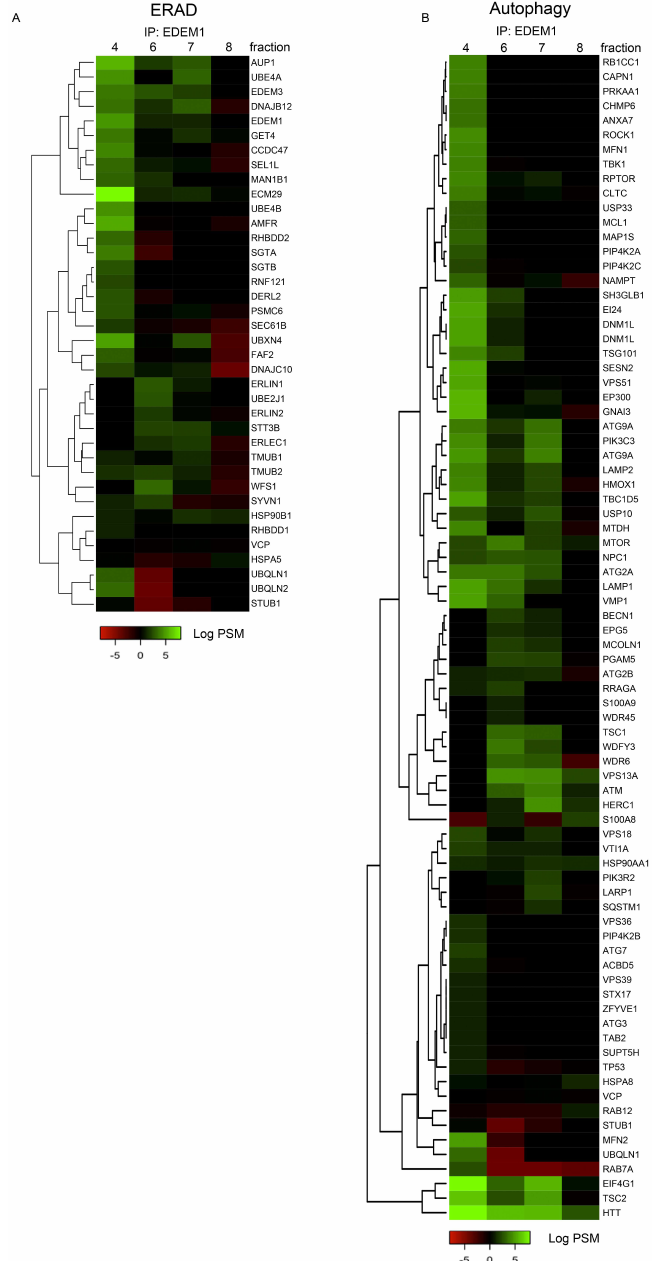
Figure A3. Heatmap of ERAD ( A) and autophagy ( B ) proteins identified, using mass spectrometry for the indicated sucrose gradient fractions that were immunoprecipitated with EDEM1; the eluted samples were separated by SDS-PAGE, followed by in the gel digestion protocol, as described in the Materials and Methods section. Identified proteins were annotated with GO terms from UniProt database, and entries containing the ERAD ( A ) and autophagy ( B ) key-terms were further analysed. Positive values, after negative control subtraction of spectral counts in log scale corresponding to each extraction condition, are represented as a